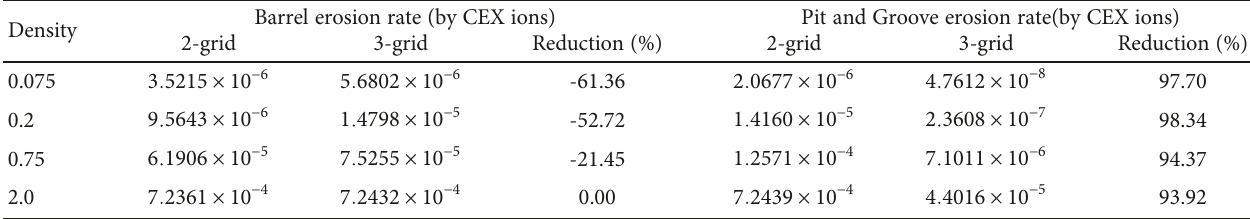
Table 5: Average erosion rate of 2-grid and 3-grid optical systems (unit: m/1000 h).